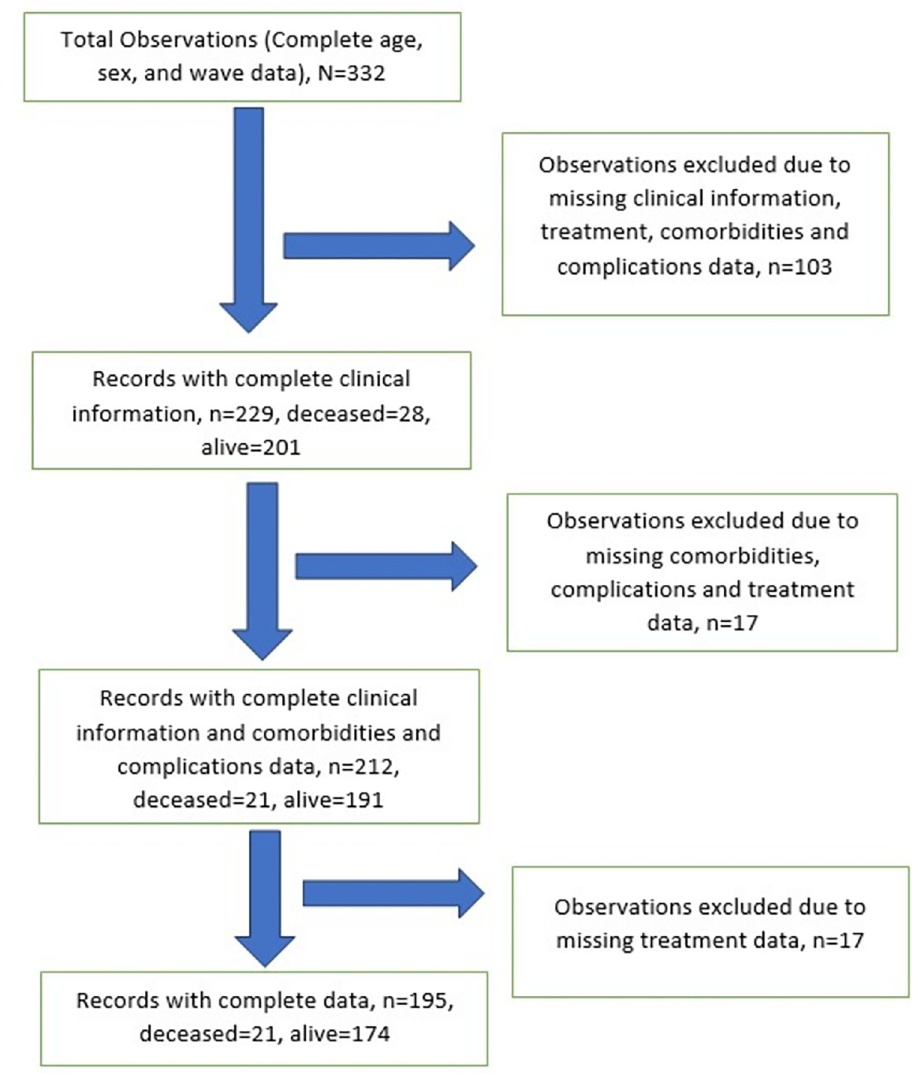
Fig 1. Flow diagram of patient selection (note that some observations have missing data on more than one variable).